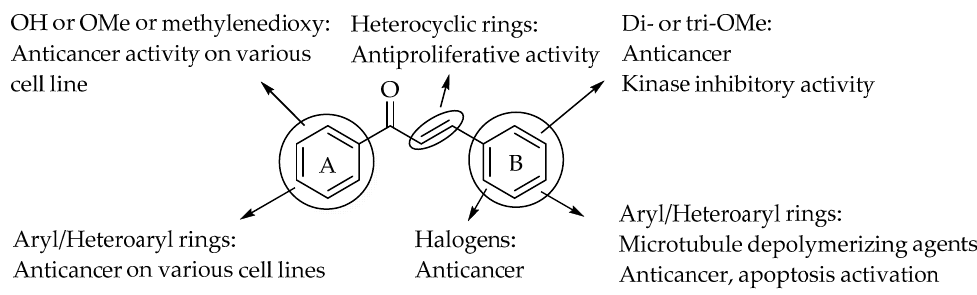
Figure 1. Structure- anticancer activity relationship of chalcone compounds [30].